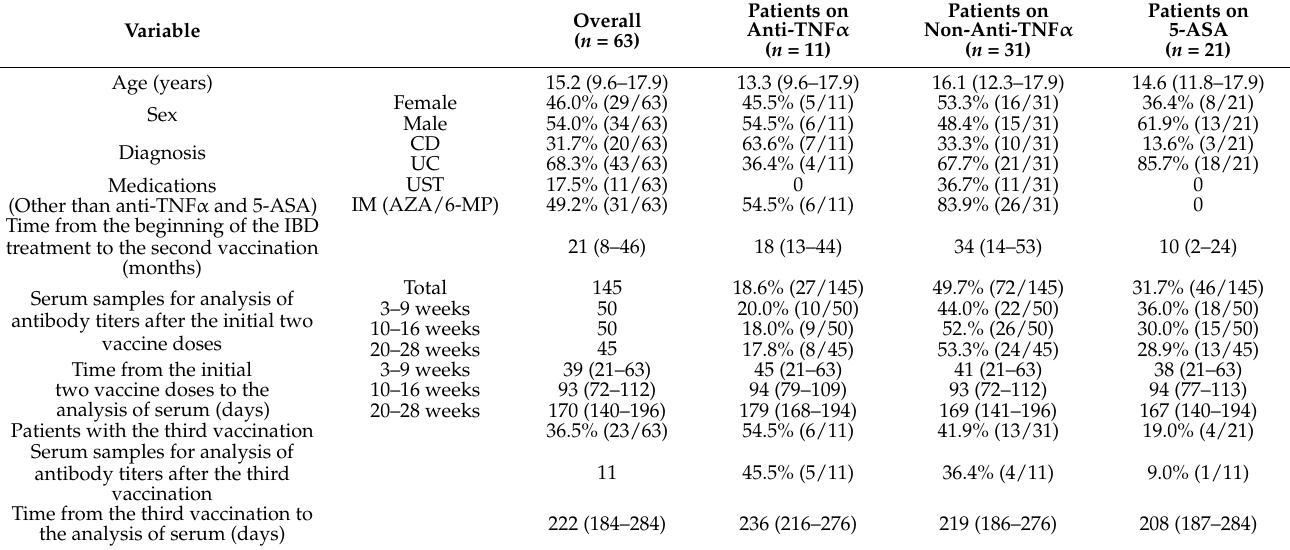
Table 1. Participants’ baseline